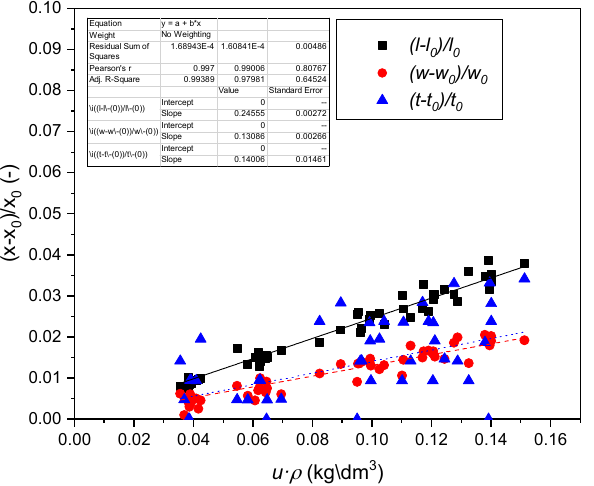
Figure 2. Swelling of normal wood as a function of the product density times moisture content.